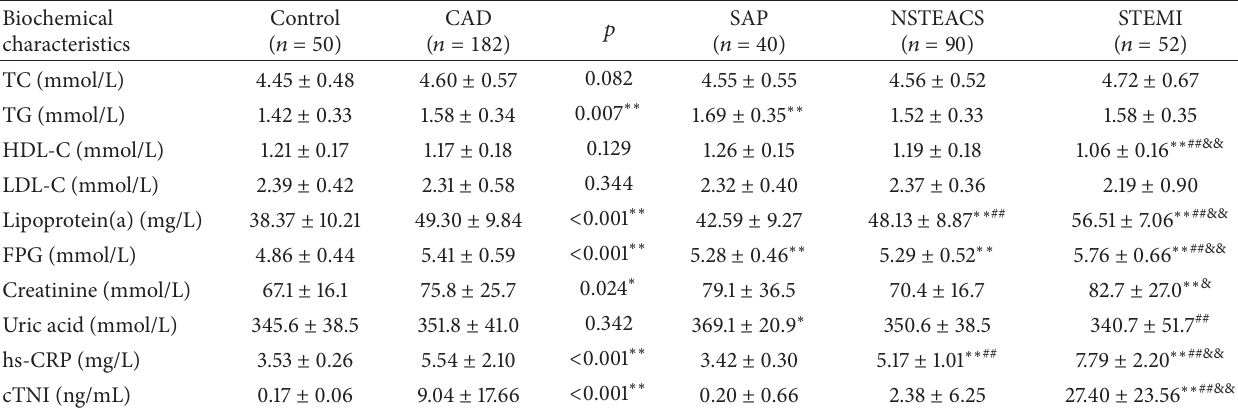
Table 2: Biochemical characteristics of